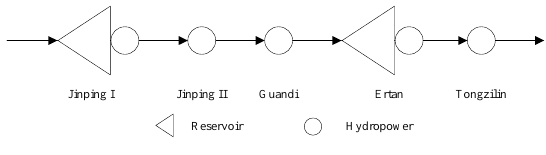
Fig. 3. Topological diagram of the